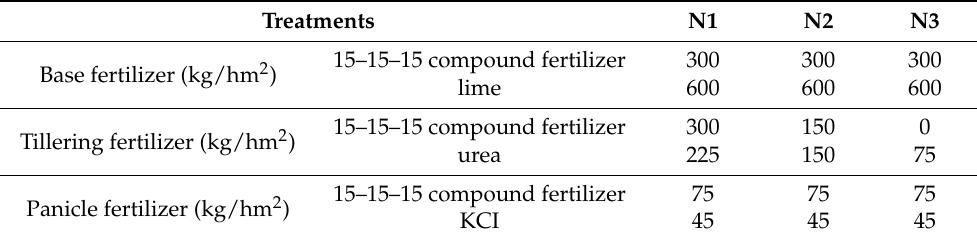
Table 1. Fertilizer treatments in the experiment.